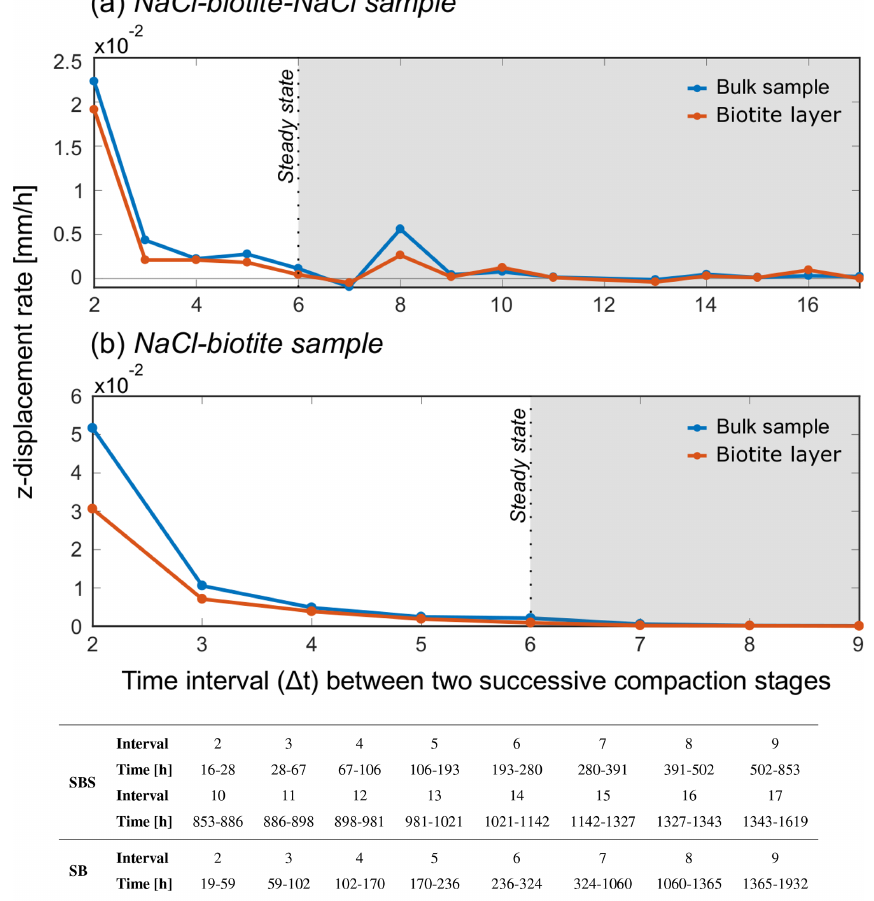
Figure 8. The graph shows the vertical displacement rate of the bulk sample and the biotite-bearing layer for different increments of pro- gressing deformation over the duration of the experiments. Panel (a) contains data from the SBS sample and (b) from the SB sample. Before the apparent steady-state deformation the bulk samples compact faster than the biotite-bearing layer. This trend continues into the appar- ent steady state (grey-shaded area) although both rates become comparable to each other, indicating that the biotite-bearing layer is not compacting faster than the bulk sample.